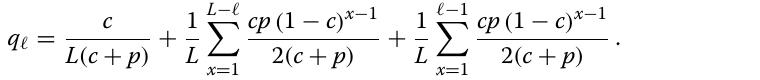
agents to move in a discrete, infinitely long, one-dimensional lattice with periodic bound- ary conditions (that is, a ring). The L locations occupy consecutive positions on the lattice (labeled from 1 to L ), and a fixed number of n = N / L agents belong to each one, as their base